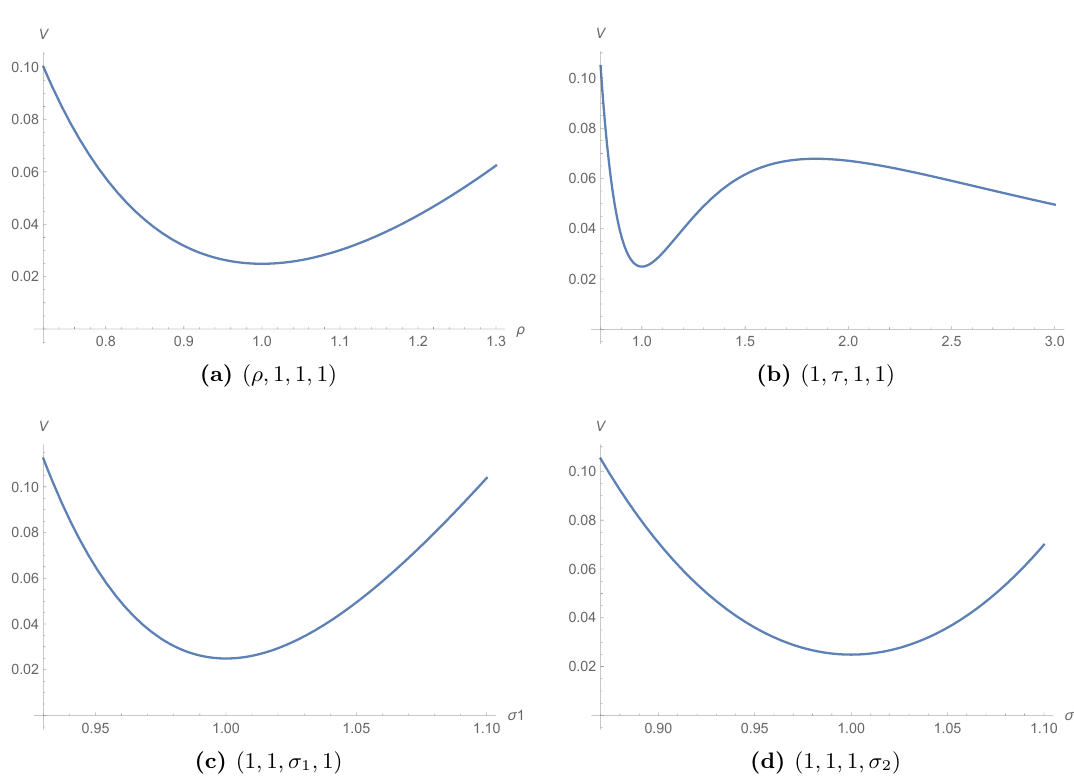
Figure 2. Slices of the potential 2 Sitter extremum at (cid:30) i =